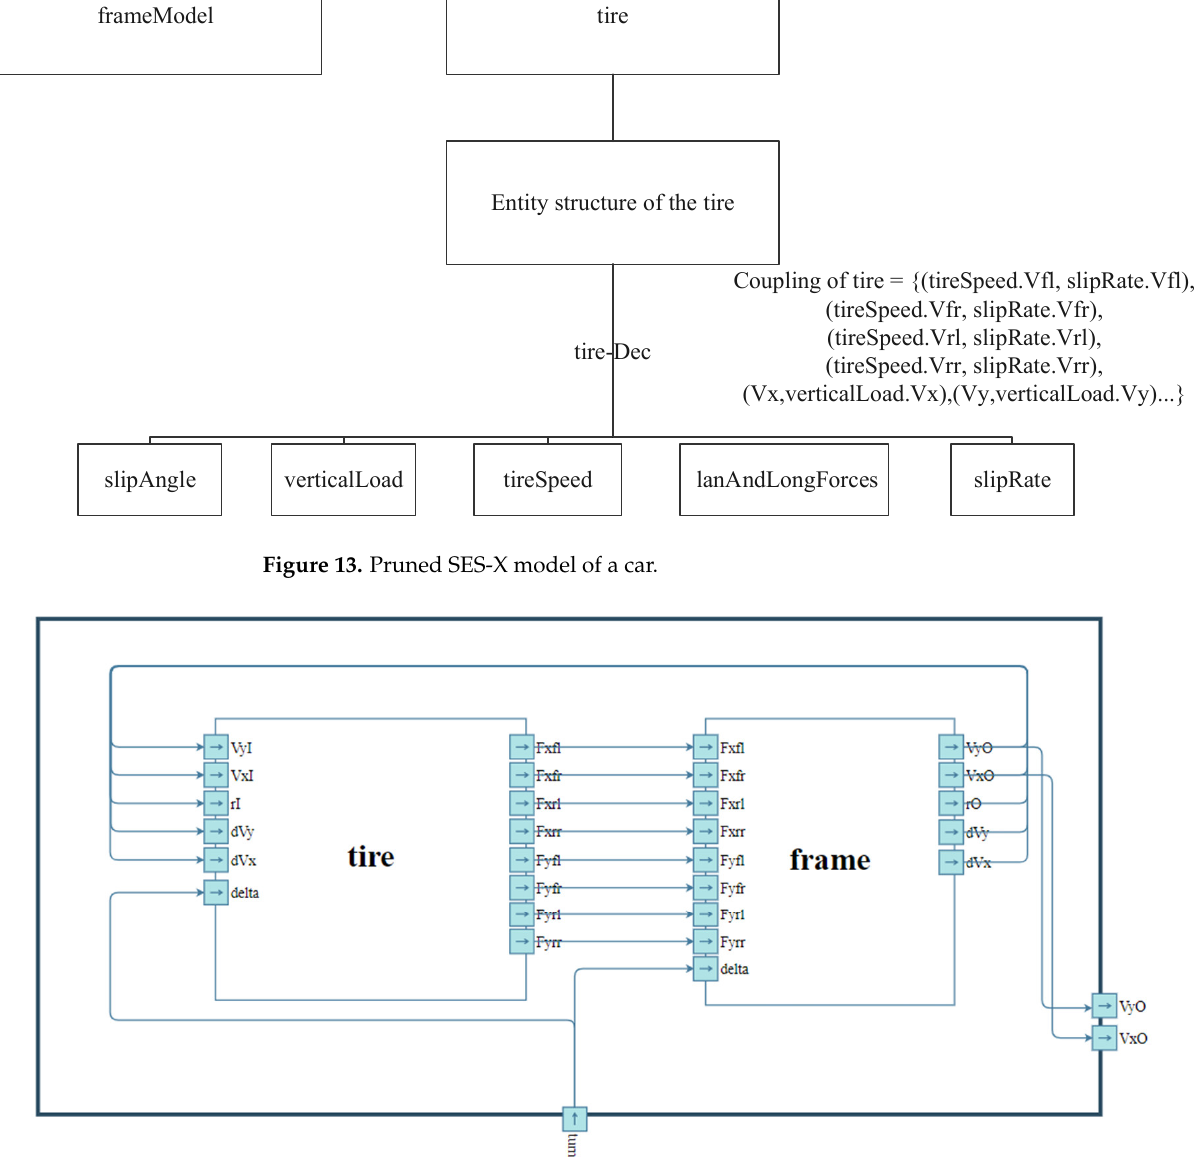
Figure 13. Pruned SES-X model of a car.